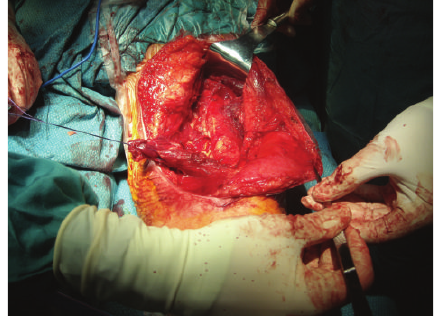
Figure 6: Flap of the distal insertion of the vastus medialis and medial aspect of the intermuscular septum after resection of the tumor.